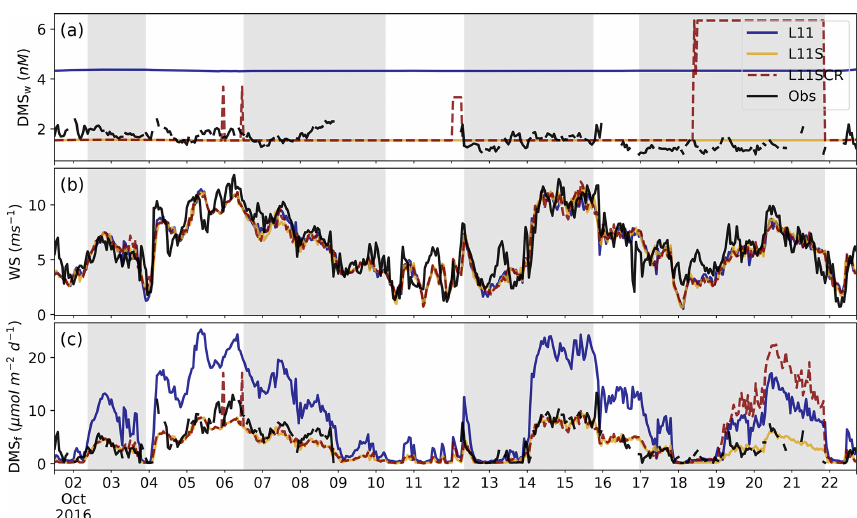
Figure 2. RVI observations (black) and model estimates (coloured) of (a) DMS w (nM), (b) wind speed (ms − 1 ) and (c) the flux DMS (µmolm − 2 d − 1 ). Note the flux DMS is calculated from observations using the Liss and Merlivat (1986) parameterisation. The three WRF- Chem simulations are L11 (blue), L11S (yellow) and L11SCR (dashed red). The grey shading from left to right indicates when the ship was at station locations 2, 3.1, 3.2 and